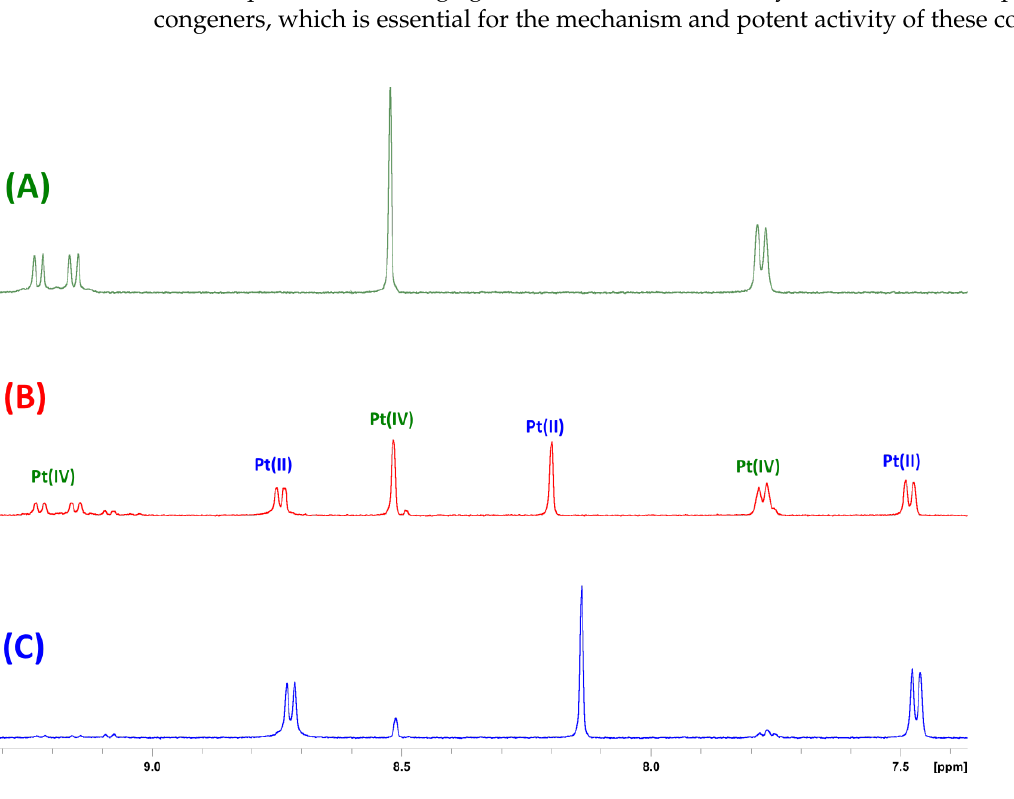
Figure 7. The 1 H NMR spectra of the aromatic region of 3 with 10X PBS in D 2 O (5 mM) at 37 °C ( A ) before the addition of ascorbic acid; ( B ) after the addition of ascorbic acid (5 mM), showing the Pt(IV) and new Pt(II) resonances; ( C ) after reduction to Pt(II).